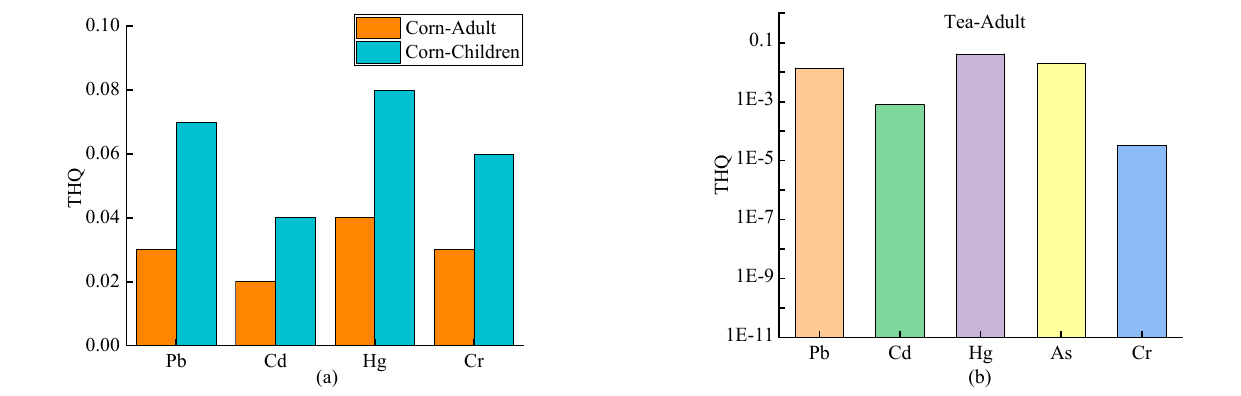
Figure 5. Results of the target hazard quotients: ( a ) the THQ assessment of corn consumption; and ( b ) the THQ assessment of drinking tea.